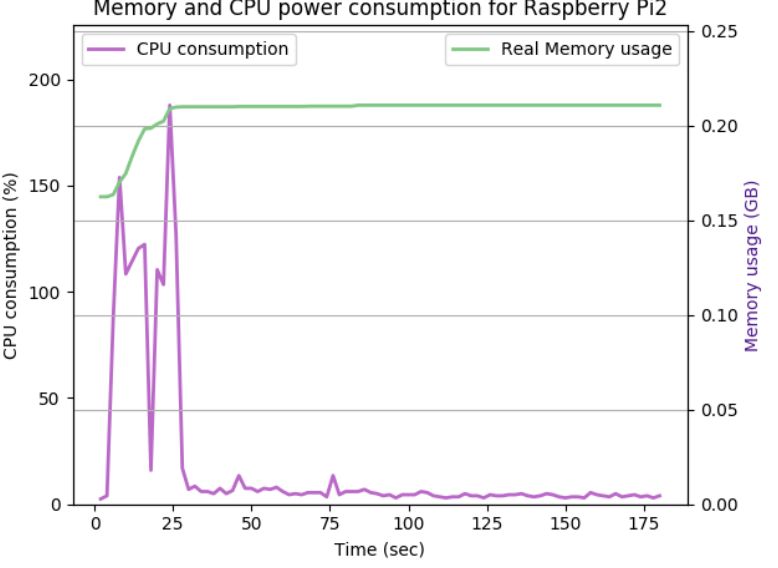
Figure 19. The CPU and memory utilization of the Raspberry Pi device using TLS_ECDHE_RSA_WITH_AES_128_GCM_SHA256, keysize =